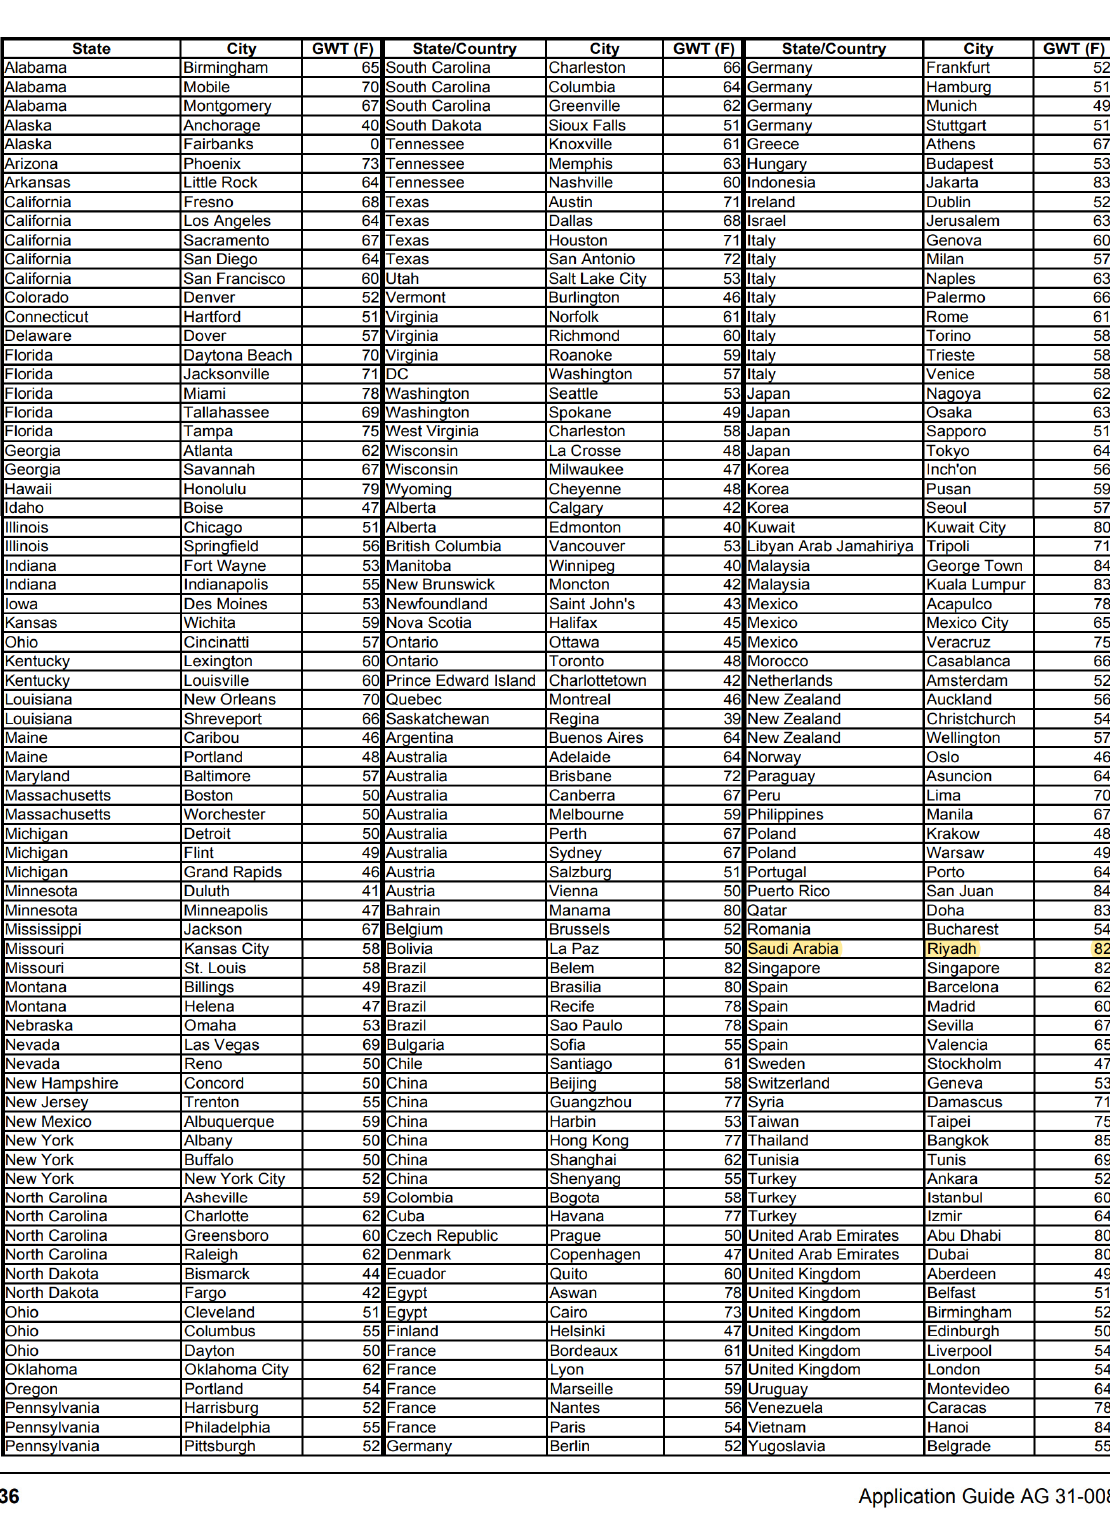
Figure A4. Ground temperature.